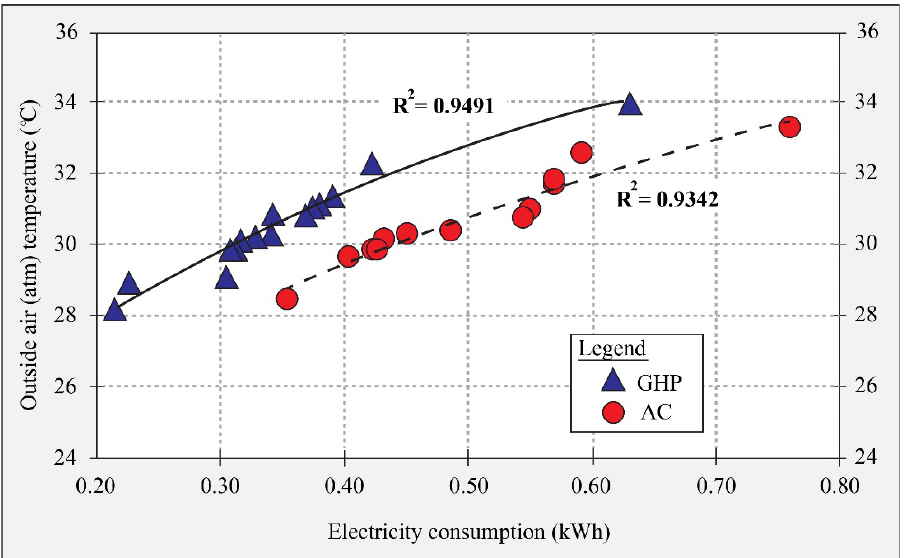
Figure 9. Comparison of electricity consumption and outside air temperatures (ATM) when operating at 25 °C in long-term measurement (July 2015 to September 2016) at the experimental room, Parot Racha Building, Chulalongkorn University.